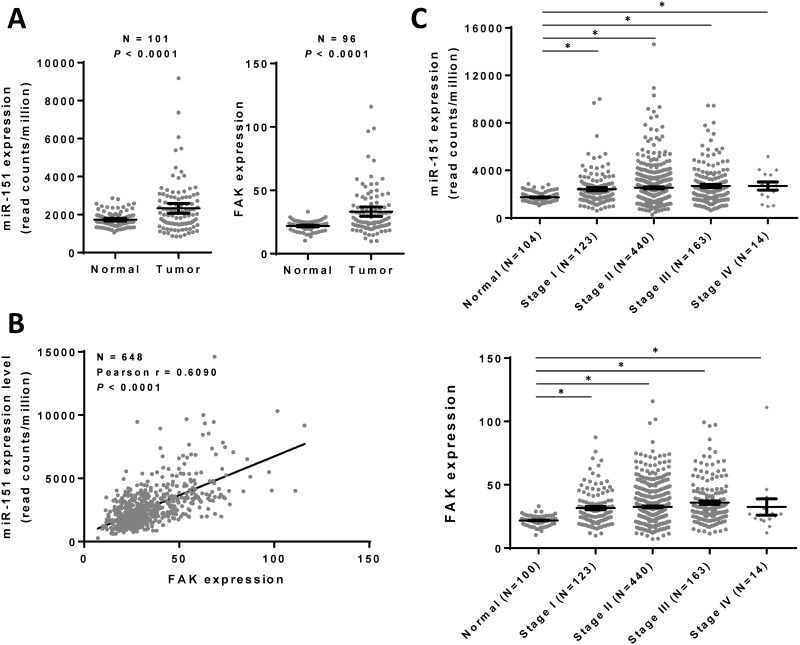
miR-151 expression is higher in breast cancers than in their corresponding adjacent normal tissues.(A) The miR-151 and FAK expression levels of breast cancer samples and the corresponding adjacent normal tissue samples were downloaded from the “The Cancer Genome Atlas” (TCGA) and the Broad GDAC Firehose data portal. The miR-151 reads per million reads of all samples were selected and analyzed to compare abundances. (B) As described above, the miR-151 and FAK expression levels of breast cancer samples (N = 648) were downloaded. The correlation between miR-151 and FAK expression levels was analyzed. (C) As described above, the miR-151 and FAK expression levels of breast cancer samples were downloaded and then divided according to the stage classification. *, P < 0.05 as compared with normal breast tissues. The results shown here are reported in their entirety based upon data generated by the TCGA Research Network: http://cancergenome.nih.gov.